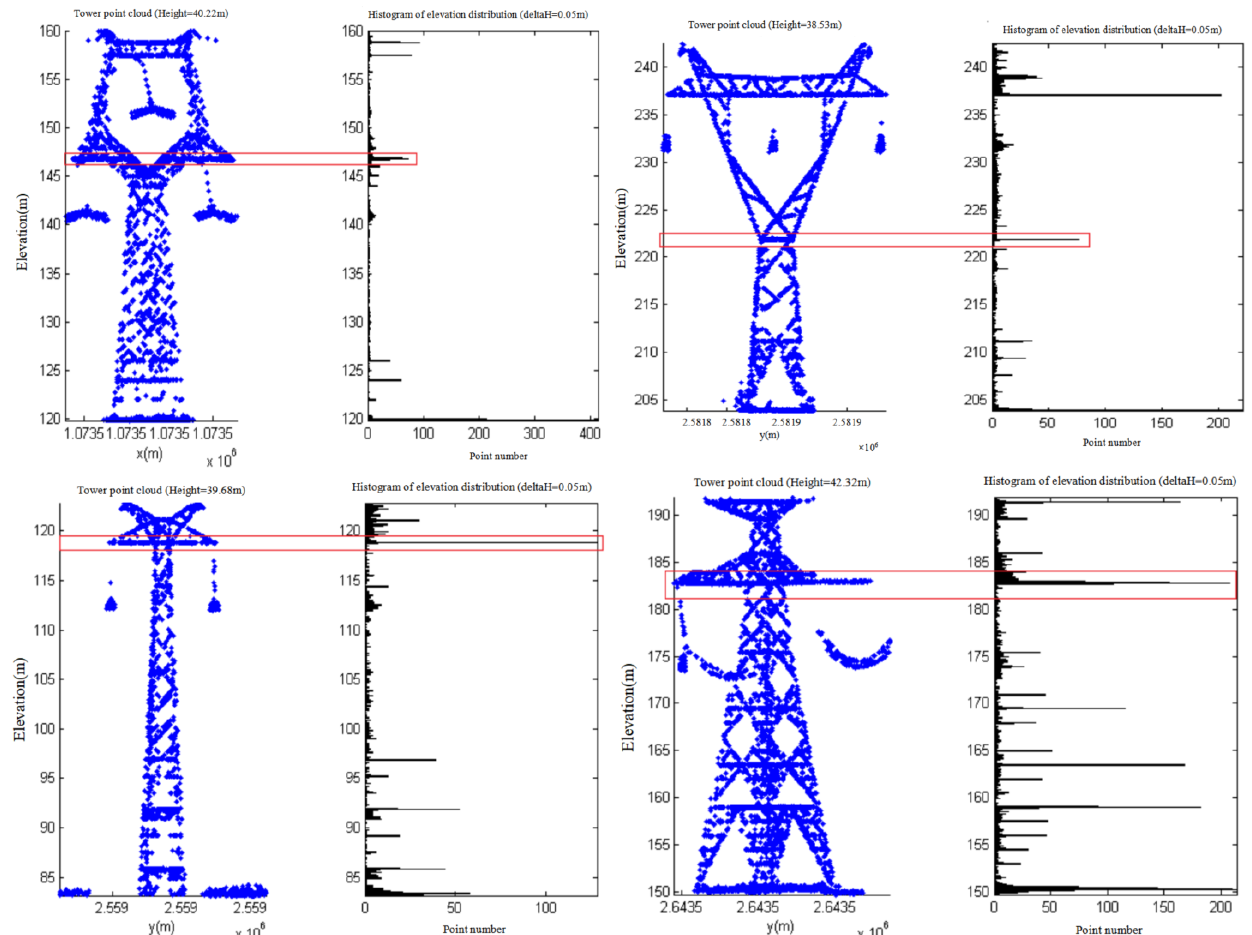
Figure 7. Segmentation based elevation of tower head and tower body.